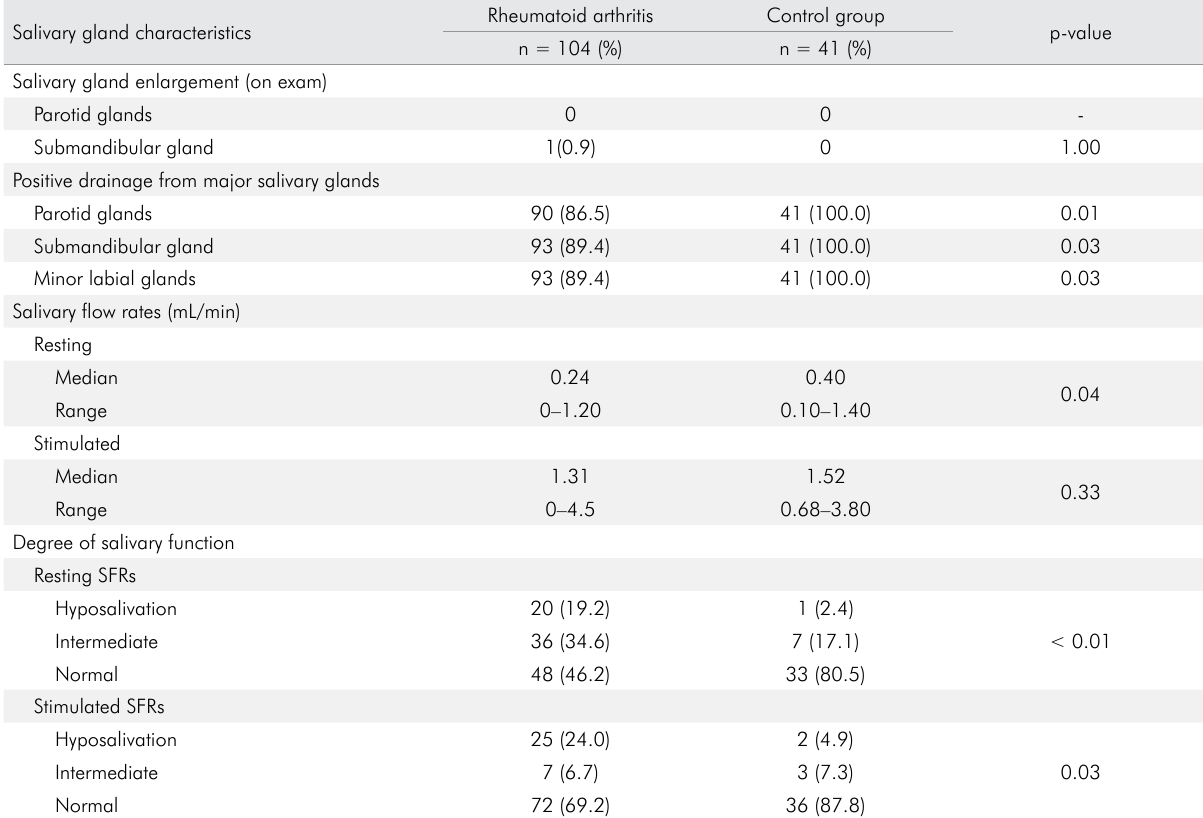
Table 3. Salivary gland characteristics of the 145 studied